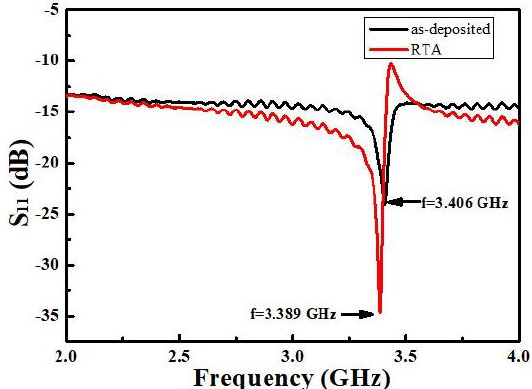
Figure 8. The frequency responses of FBAR devices with and without RTA annealing.